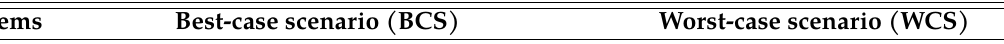
Table 2: Evaluation of the entropic state of the system for the Best and Worst-case scenarios, attending an employee perception in terms of his/her answer to the ARS –